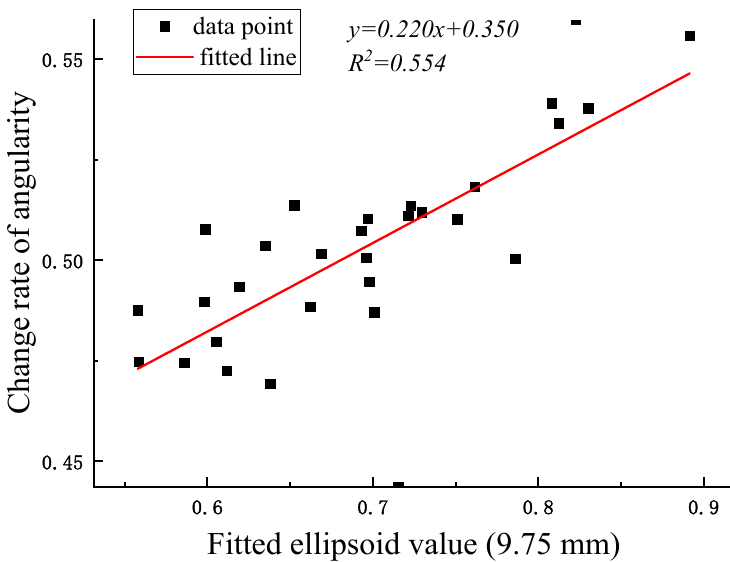
Figure 17. Correlation between fitted ellipsoid value and change in angularity (9.75 mm).